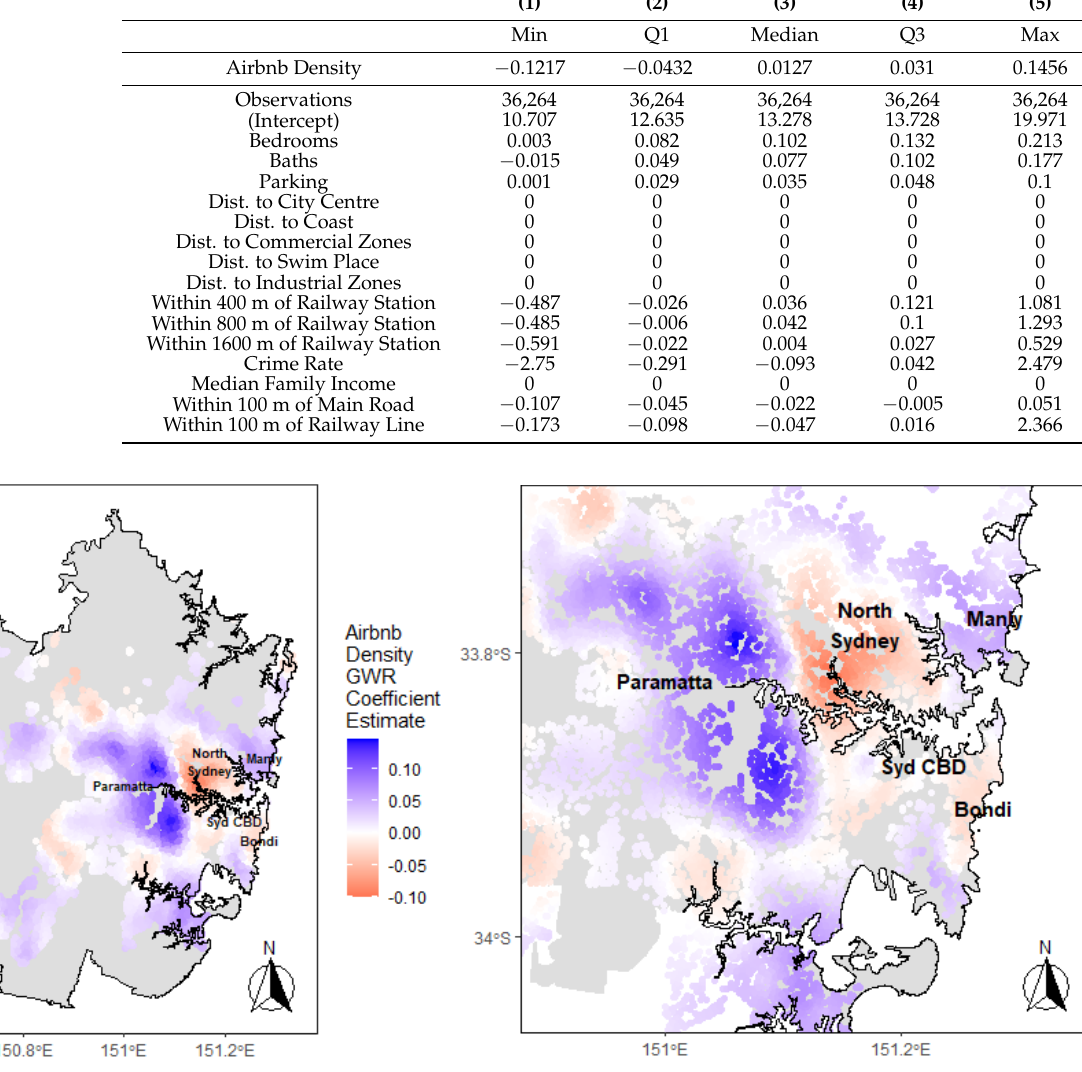
Table 4. GWR Model Results.